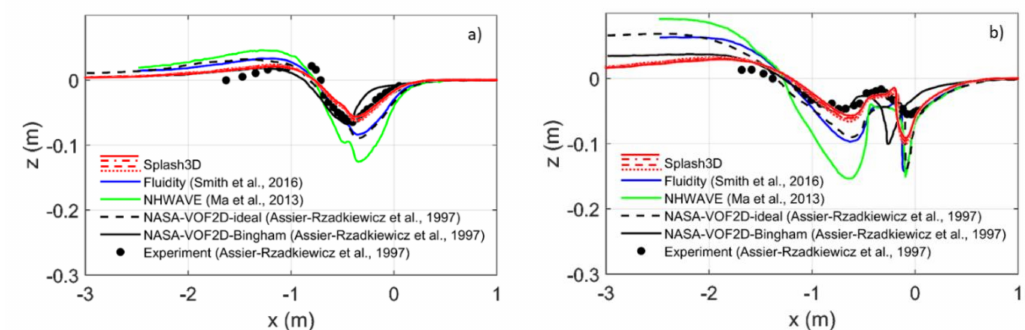
Figure 5. A comparison of free-surface elevations of four numerical models: Splash3D (red lines—di ff erent lines indicate di ff erent resolutions with dx = dz = 4.35~6.25 mm, Fluidity from Smith (blue lines), non-hydrostatic wave (NHWAVE) from Ma (green lines), NASA-VOF2D from Assier Rzadkiewicz (black lines—the solid line is the ideal model result, the dashed line is the Bingham model result), and the experimental result from Assier Rzadkiewicz [16] (black dot) at ( a ) t = 0.4 s and ( b ) t = 0.8